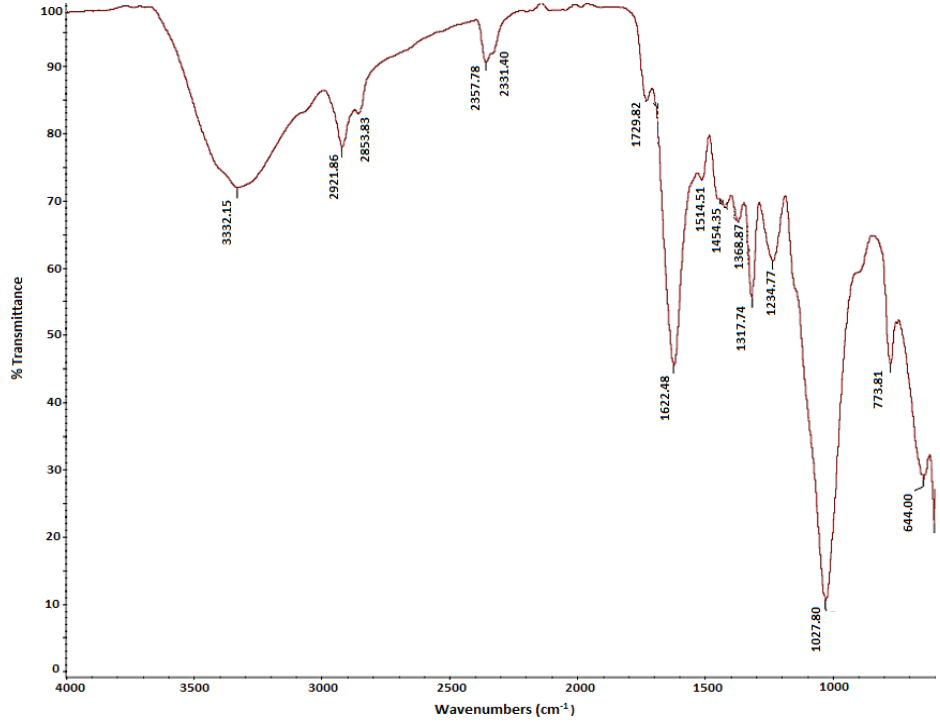
Figure 4. Fourier-transform infrared spectroscopy (FTIR) peaks for Acacia tortilis Figure 4. Fourier ‐ transform infrared spectroscopy (FTIR) peaks for Acacia tortilis.